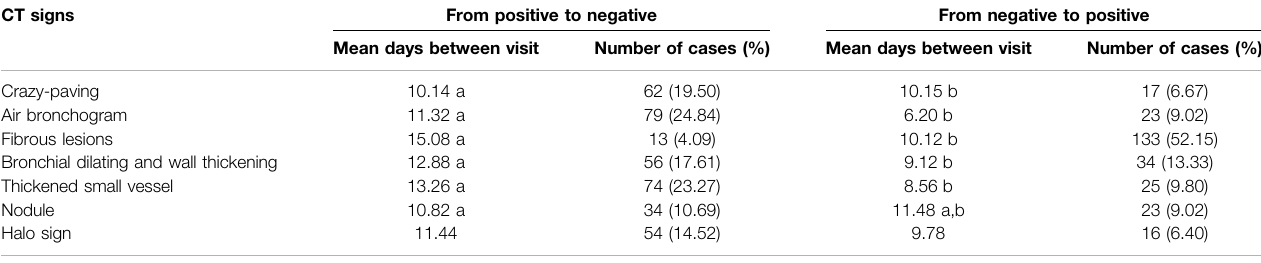
TABLE 3 | Development of CT signs. CT signs From positive to negative From negative to positive Mean days between visit Number of cases (%) Mean days between visit Crazy-paving